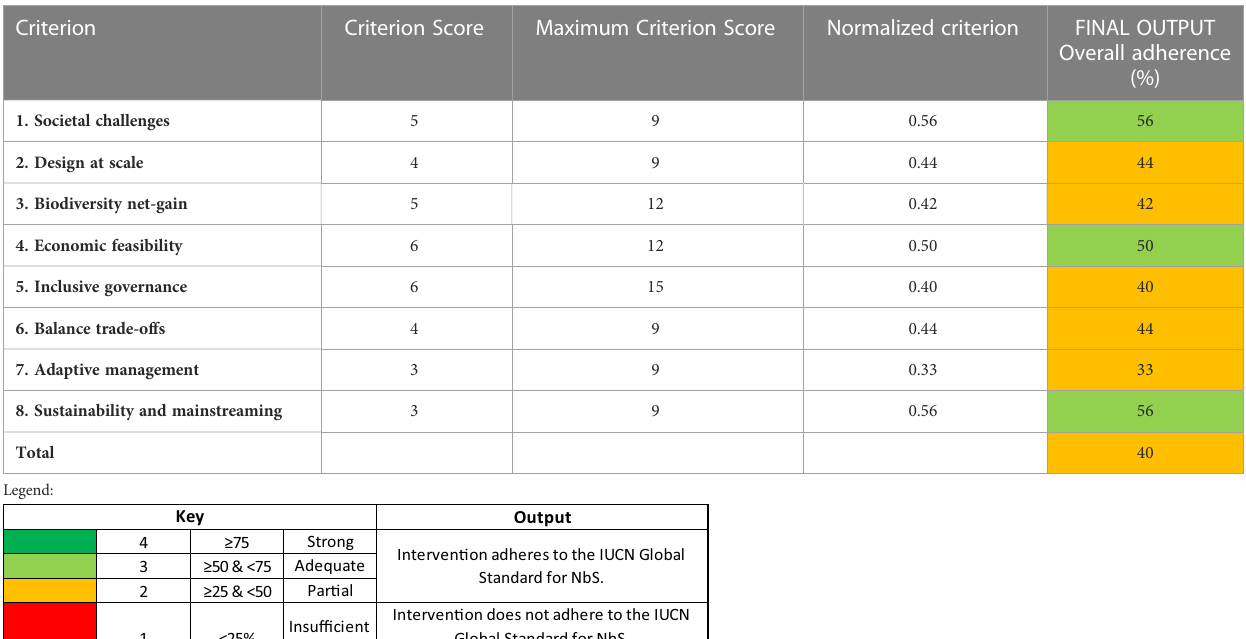
TABLE 4 Overall result of the assessment of Kalimantan Mangrove Shrimp Program in Indonesia, according to the IUCN NbS Global Standard ™ ’ s self- assessment tool (results were discussed and re fi ned with the BNCFF team).